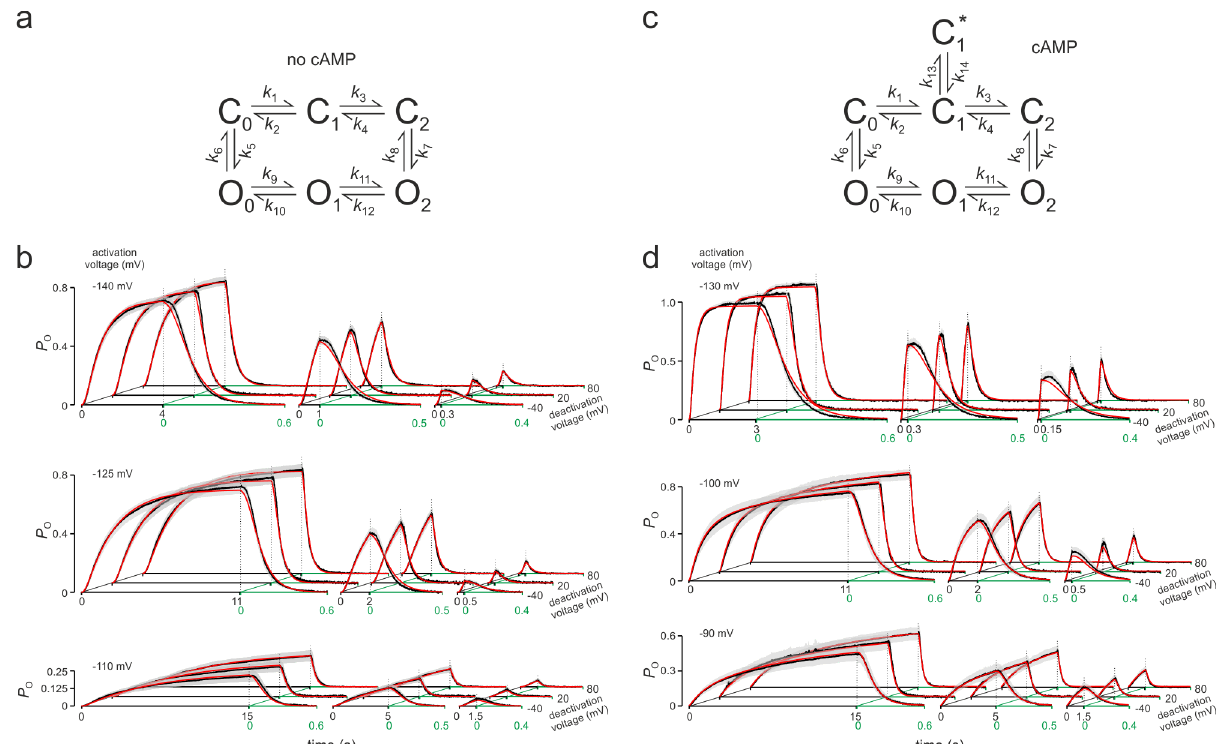
Fig 2. Global fit of activation and deactivation time courses in either the absence or presence of cAMP. (a) Scheme of model 1 n . (b) Fit of the 27 time courses of activation and deactivation in the absence of cAMP. (c) Scheme of model 1 a . (d) Fit of the 27 time courses of activation and deactivation in the presence of 10 μ M cAMP. The experimental traces and fitted curves are given in black and red color, respectively. Shades of gray indicate s.e.m. The parameters are provided by Table